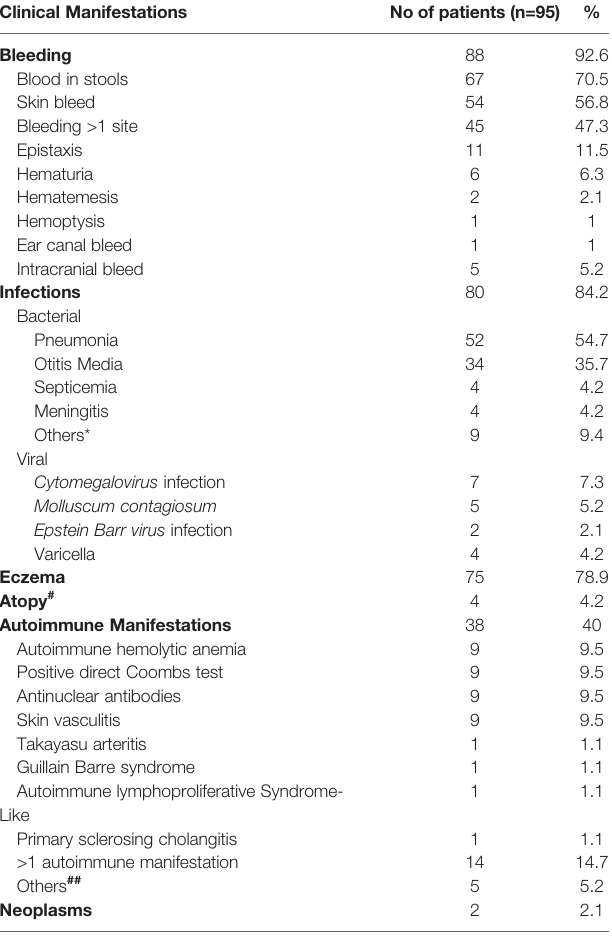
TABLE 3 | Clinical manifestations encountered in patients over 217 patient years of follow-up (n=95). Clinical